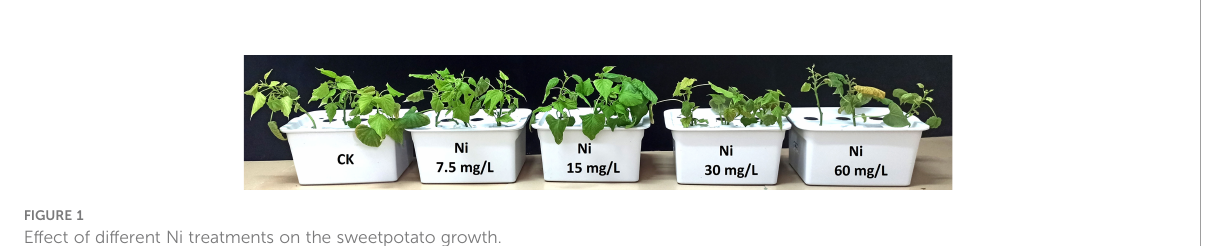
FIGURE 1 Effect of different Ni treatments on the sweetpotato